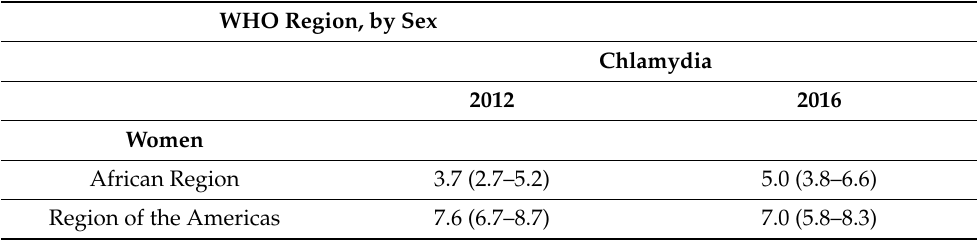
Table 1. Data regarding Chlamydia trachomatis infection prevalence in the continents, estimates of 2012 and 2016, in women and men (Bulletin WHO)